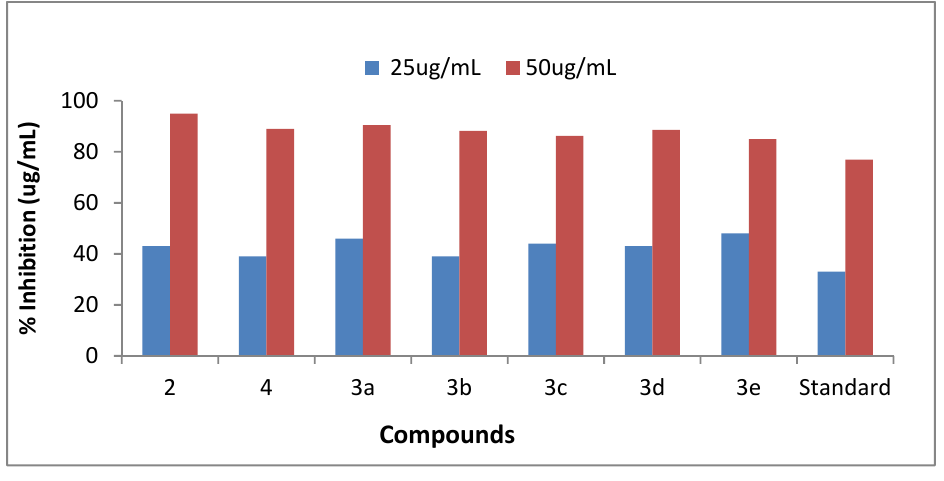
Figure 1. The urease inhibition activity graph.